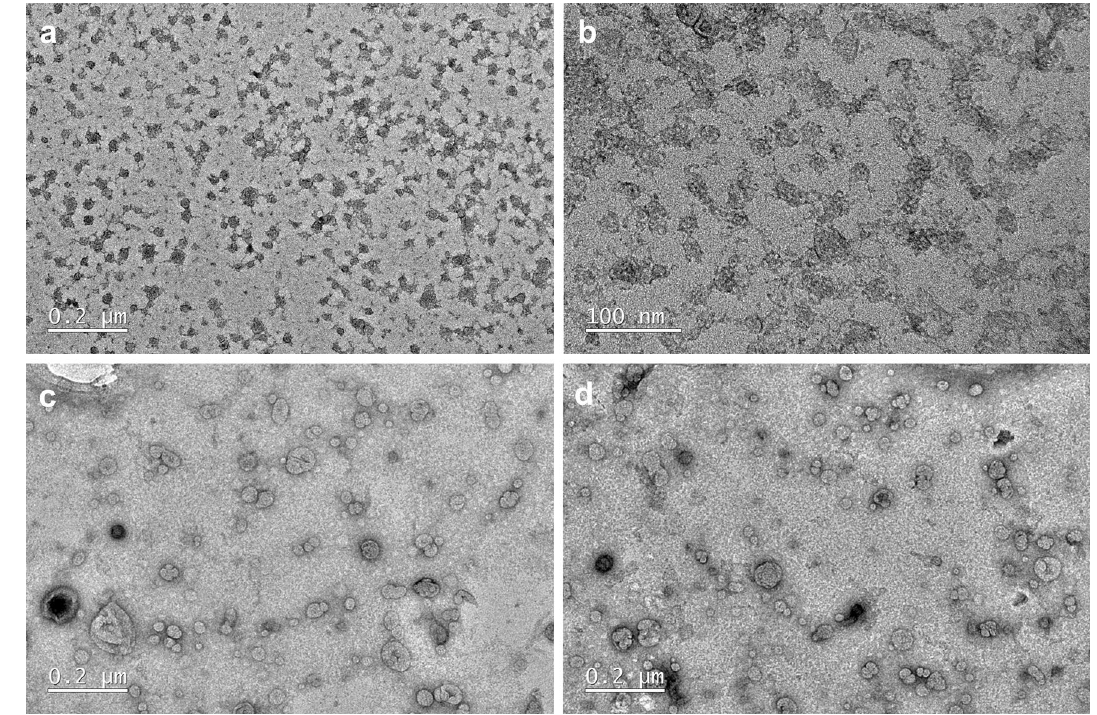
Figure 1. TEM images of LF particles alone ( a , b ) and in nanomeric complex with DNA ( c , d ).